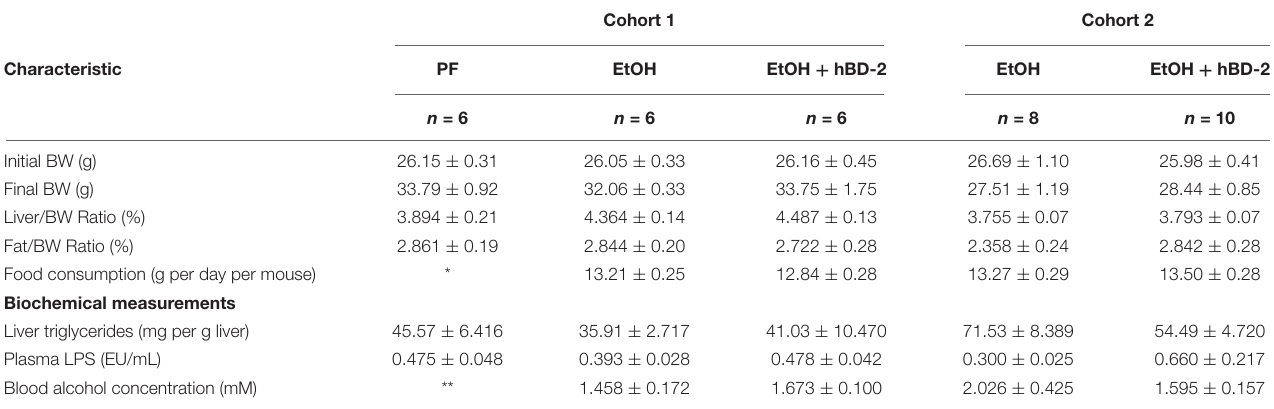
TABLE 2 | Metabolic characteristics of the experimental mice.